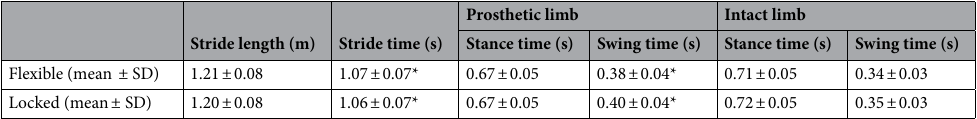
Table 2. Redimensionalized spatiotemporal variables. *Significant difference between conditions (p < 0.05). Note, statistical analyses were performed on dimensionless